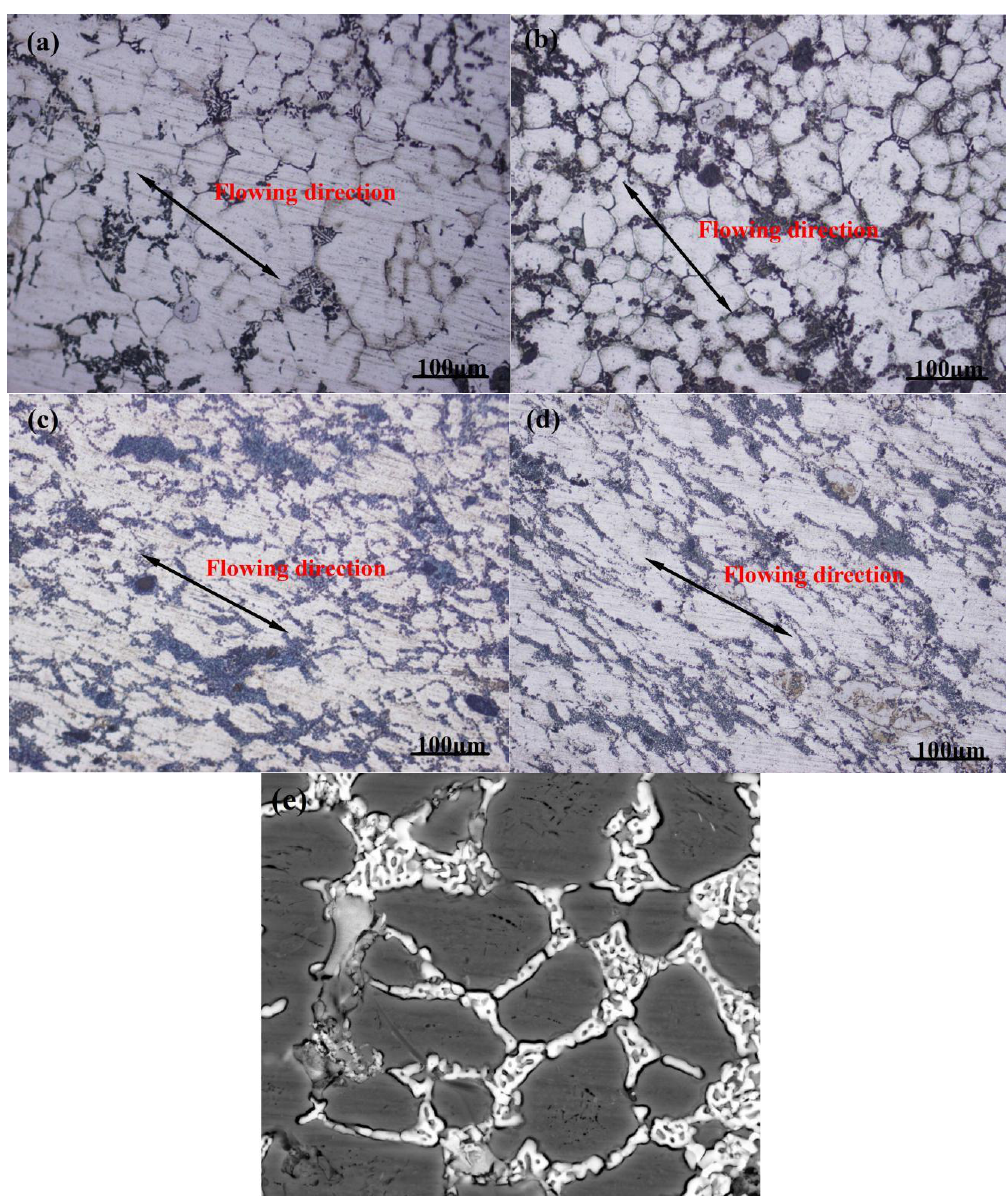
Figure 5. Microstructure of 2024 aluminum matrix composite component reinforced by 5 vol % Al 2 O 3 nanoparticles rheoformed at 620 °C and for 25 min stirring time. ( a ) Optical microscope (OM) image in location A of the composite component; ( b ) OM image in location B of the composite component; ( c ) OM image in location C of the composite component; ( d ) OM image in location D of the composite component; ( e ) SEM image in location B of the composite component.